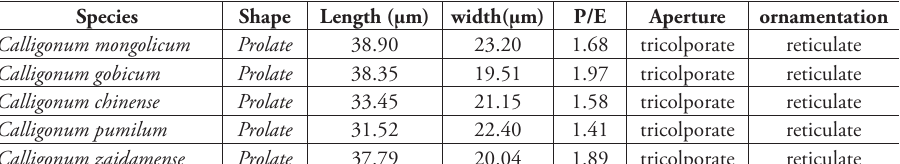
Table 5. The characteristics of the pollen grains of five species of the Calligonum mongolicum complex. Species